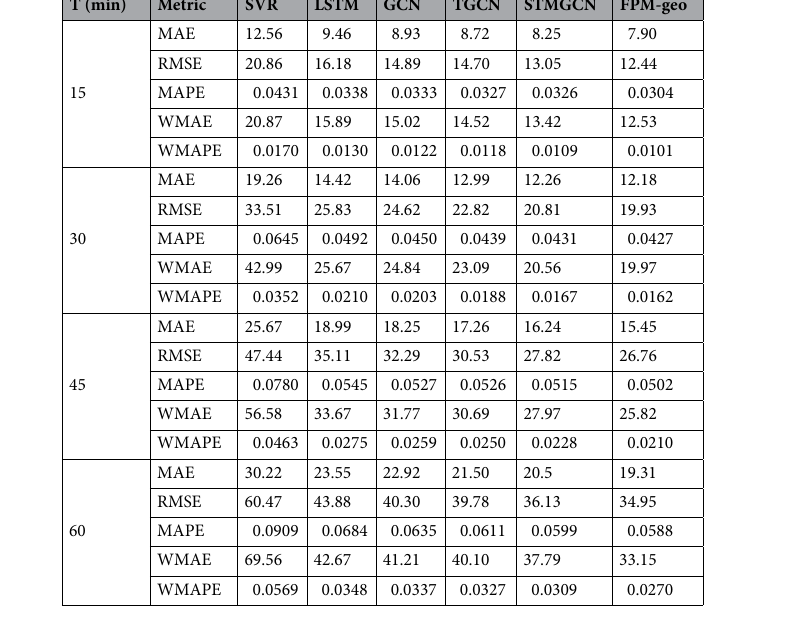
Table 1. Performance comparison among different prediction models.